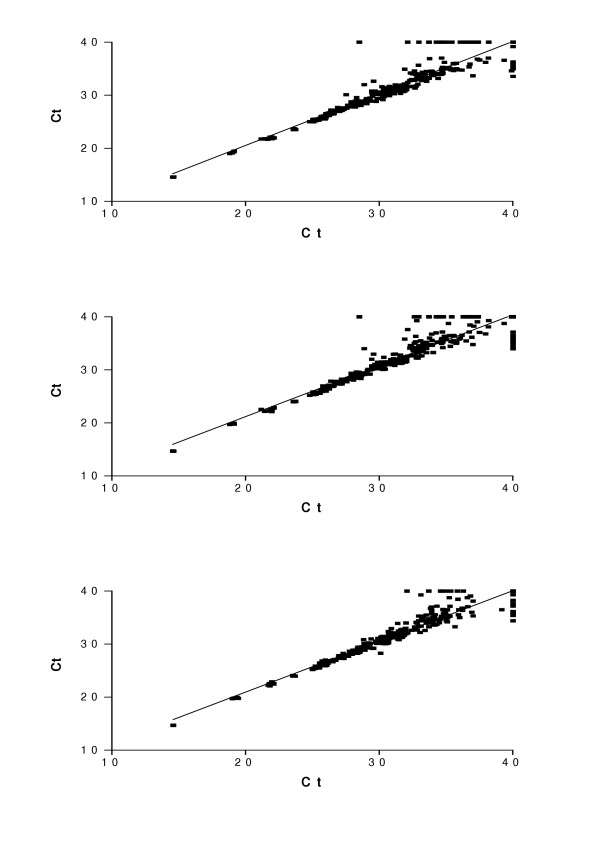
LDAs Ct (copy threshold) data plotted LDA 1 vs 2; 1 vs 3 and 2 vs 3. The x and y-axis represent Ct values obtained from LDA 1 and 2, LDA 1 and 3 and LDA 2 and 3 respectively. A line of best fit has been plotted.